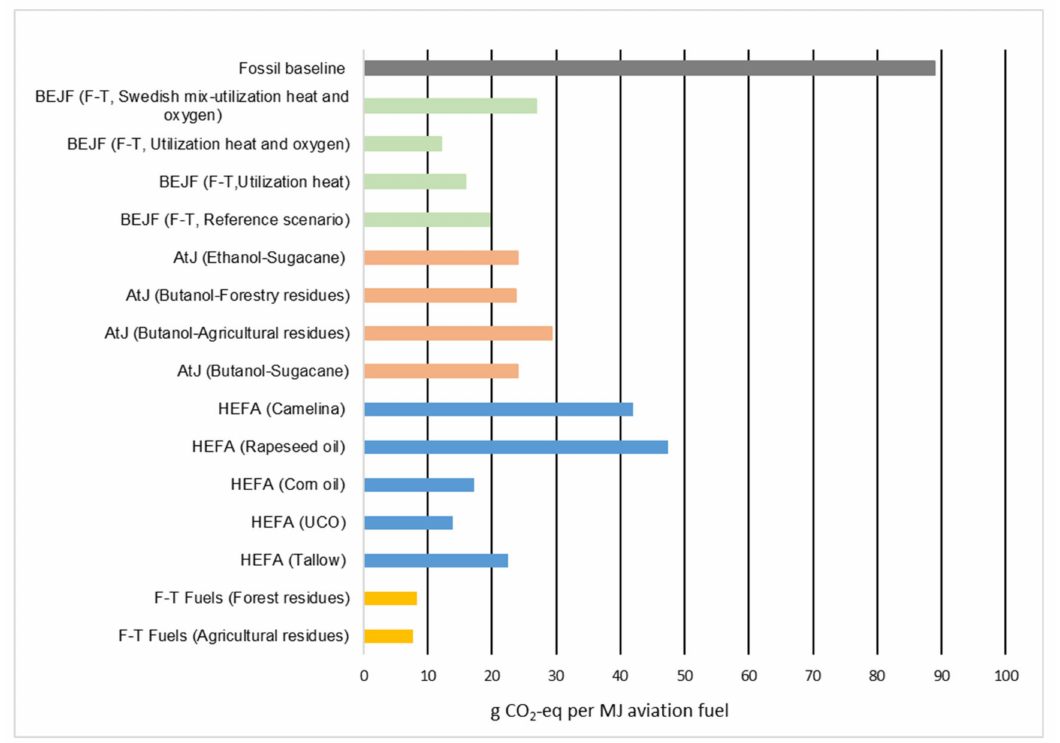
Figure 8. Comparison of the Global Warming Potential (GWP) of the investigated BEJF alternative to selected fossil and renewable aviation fuels. AtJ = Alcohol to Jet, BEJF: Bio-electro-jet fuel, F-T= Fischer–Tropsch, HEFA = Hydroprocessed Esters and Fatty Acids, UCO = Used Cooking